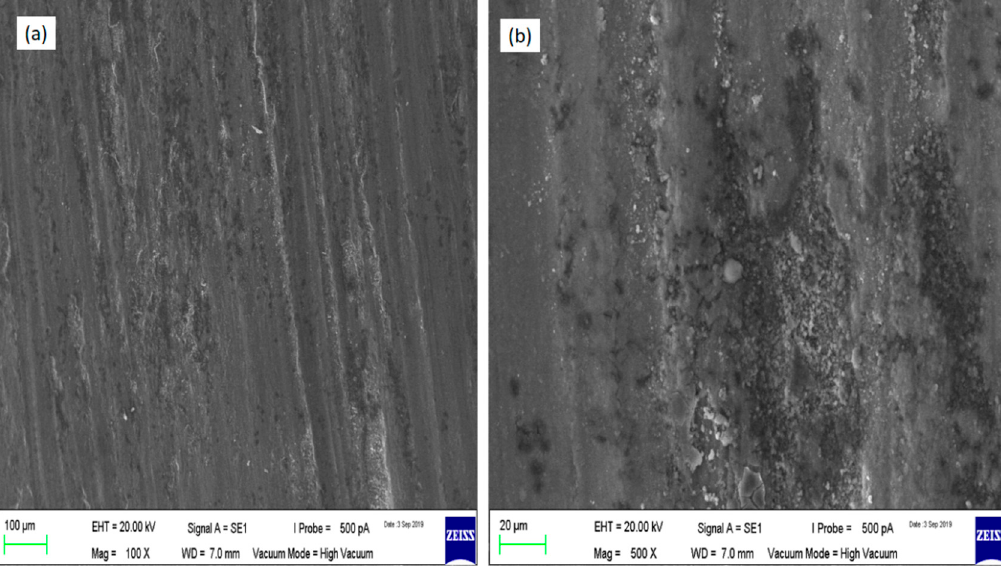
Figure 11. SEM micrographs of the wear tracks of AA7075-T651 base alloy ( a ) magnification 100× and ( b ) magnification 1000×.